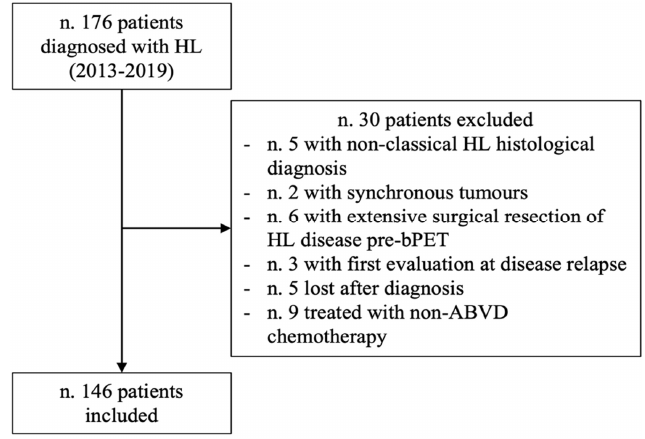
Figure 2. Flowchart of the study population. Table 1. Baseline clinical characteristics of the cohort (n = 146).